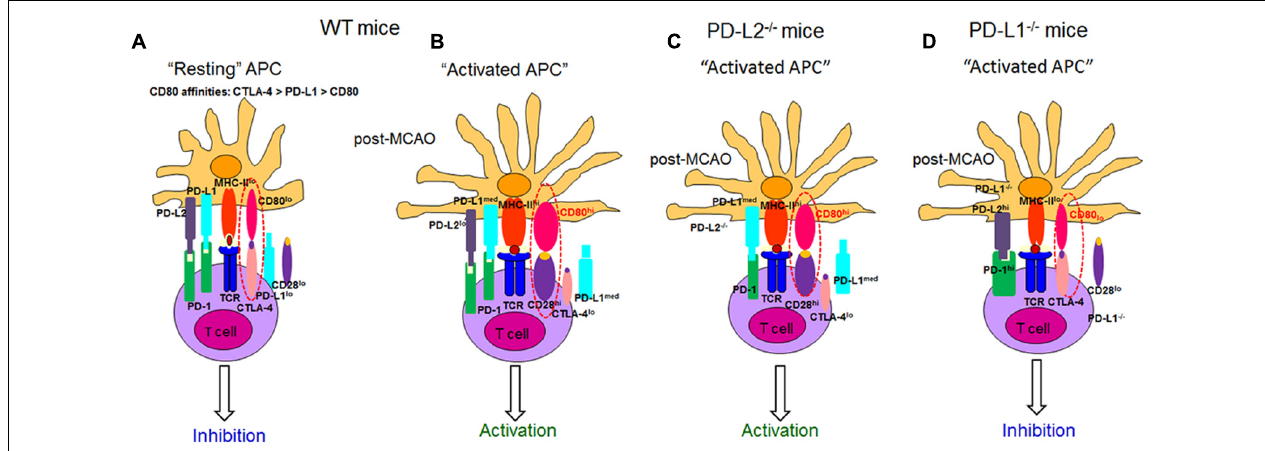
FIGURE 9 | Proposed model for the role of CD28, CTLA-4, CD80, and the PD-1/PD-L pathway in mice after ischemic stroke. The following mechanisms of action for the various co-stimulatory molecules belonging to the B7 family are postulated. The affinity of CD80 for CTLA-4, PD-L1, and CD28 are k d = 0.4, 1.4, and 4.0 μ M, respectively. Thus, at homeostatic levels, (A) PD-L1 competes with CTLA-4 for CD80 binding, thus providing in concert with MHC molecules a non-activating signal that promotes naïve T-cell survival, while simultaneously suppressing T-cell responses by outcompeting signaling through CD80/CD28. When stroke is induced in (B) WT and (C) PD-L2 − / − mice, the level of CD80 expression is significantly increased, enhancing T-cell signaling through